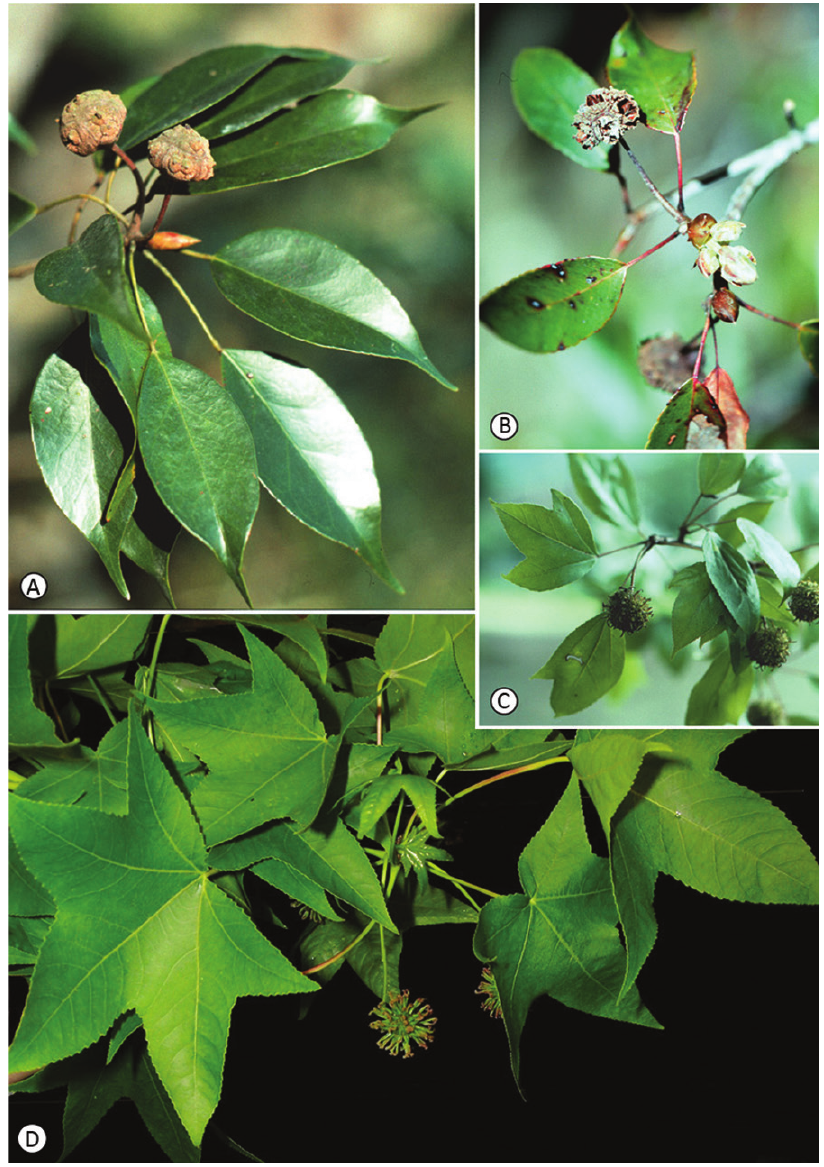
Figure 2. Morphological variation in Altingiaceae. A Liquidambar gracilipes with obconical flattened infrutescences and short styles. Leaves are simple, entire, choriaceous, and show a characteristic drip tip at the apex B Liquidambar siamensis also shows obconical flattened infructescences with simple leaves that have a serrate margin and lack of a drip tip C Liquidambar chingii showing variation in leaf morphology from palmately three-lobed leaves at left, to two-lobed leaves and simple leaves on the same branch. In- fructescences are globose with long styles D Liquidambar styraciflua showing palmately five-lobed, charta- ceous leaves, and globose infructescences with long